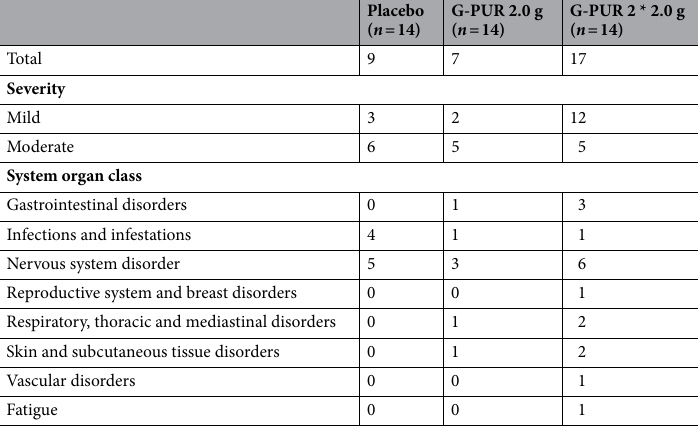
Table 4. Adverse events by treatment group, severity and system organ class